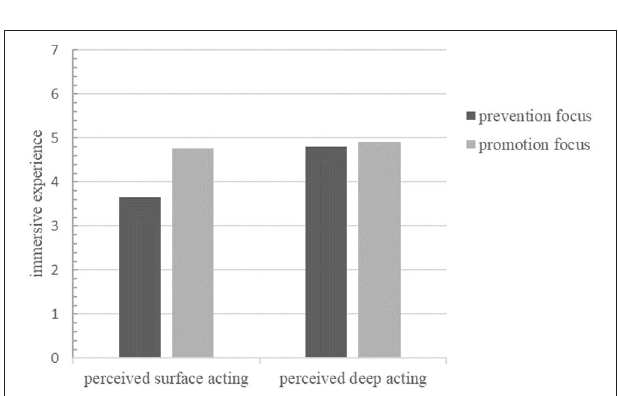
FIGURE 4 | Comparison of immersive experience with different regulatory